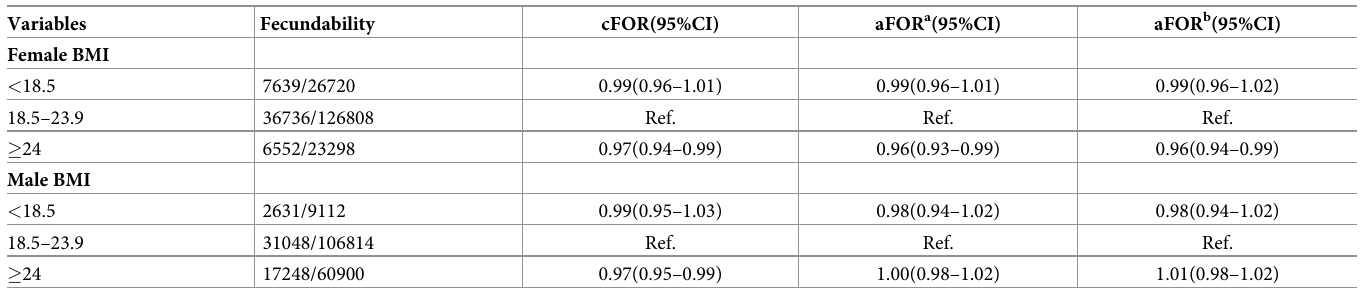
Table 3. Association between pre-pregnancy BMI and TTP in men and women, Cox regression analysis.